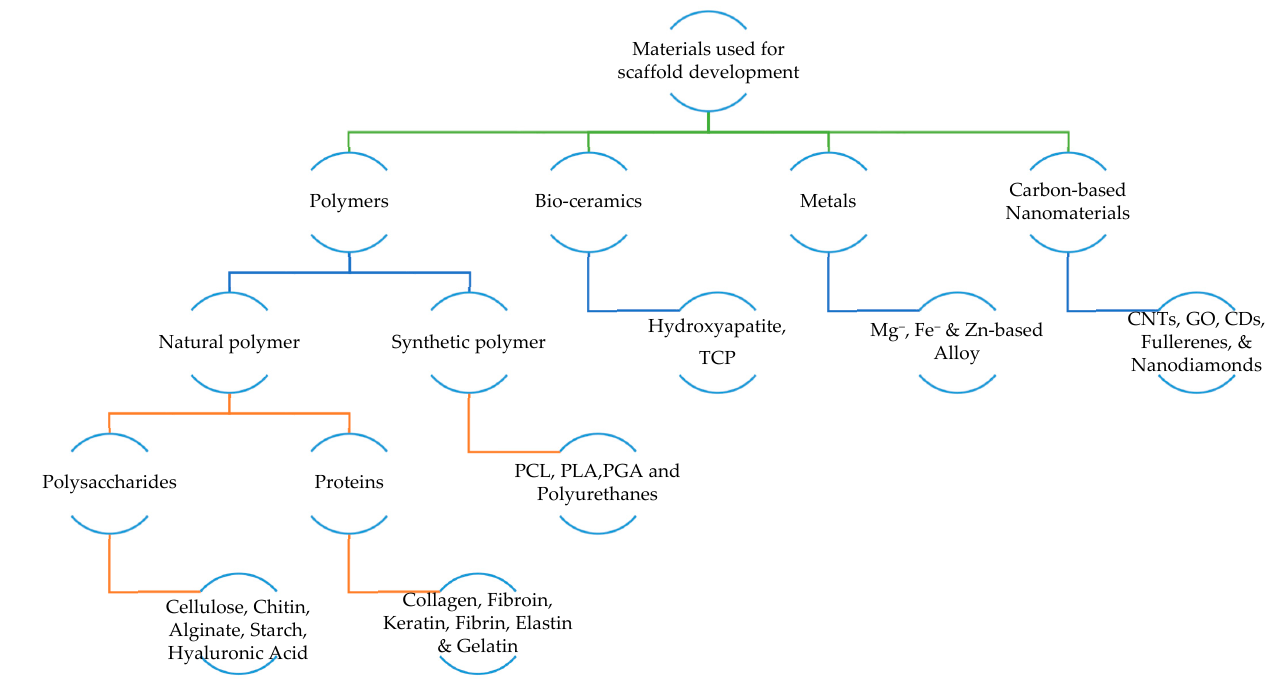
Figure 4. Materials used for scaffold development. (Materials are divided into four broad categories such as polymers, bio-ceramics, metals, and carbon nanomaterials. Classification with a few examples is summarized.)